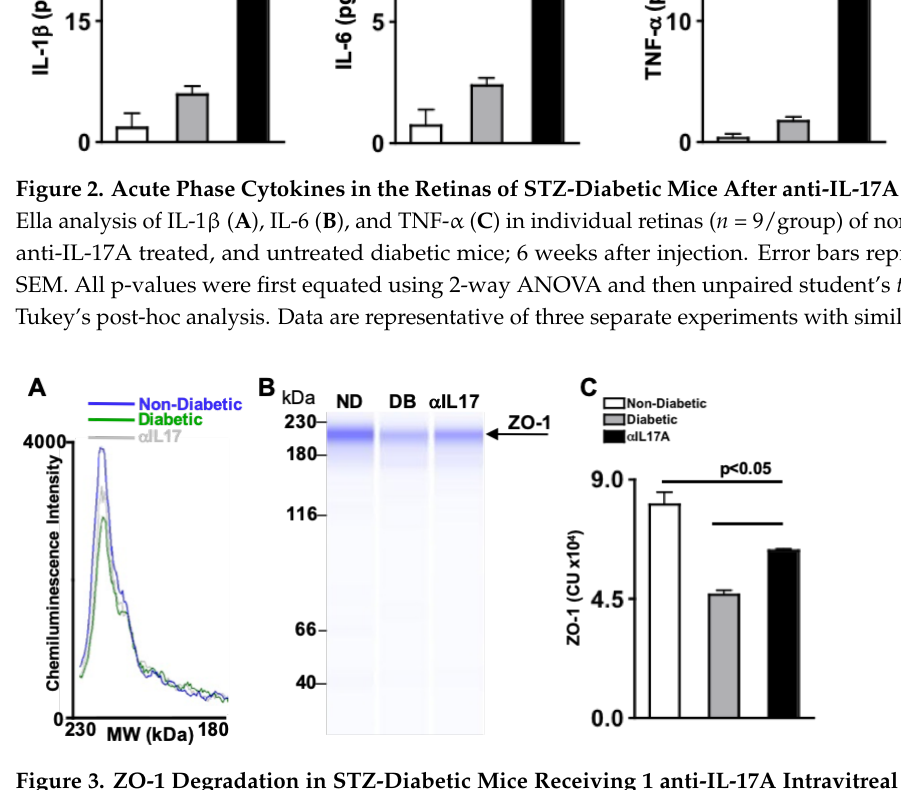
Figure 3. ZO-1 Degradation in STZ-Diabetic Mice Receiving 1 anti-IL-17A Intravitreal Injection. ( A ) Representative electropherogram of ZO-1 in retinas of non-diabetic, untreated STZ-diabetic,